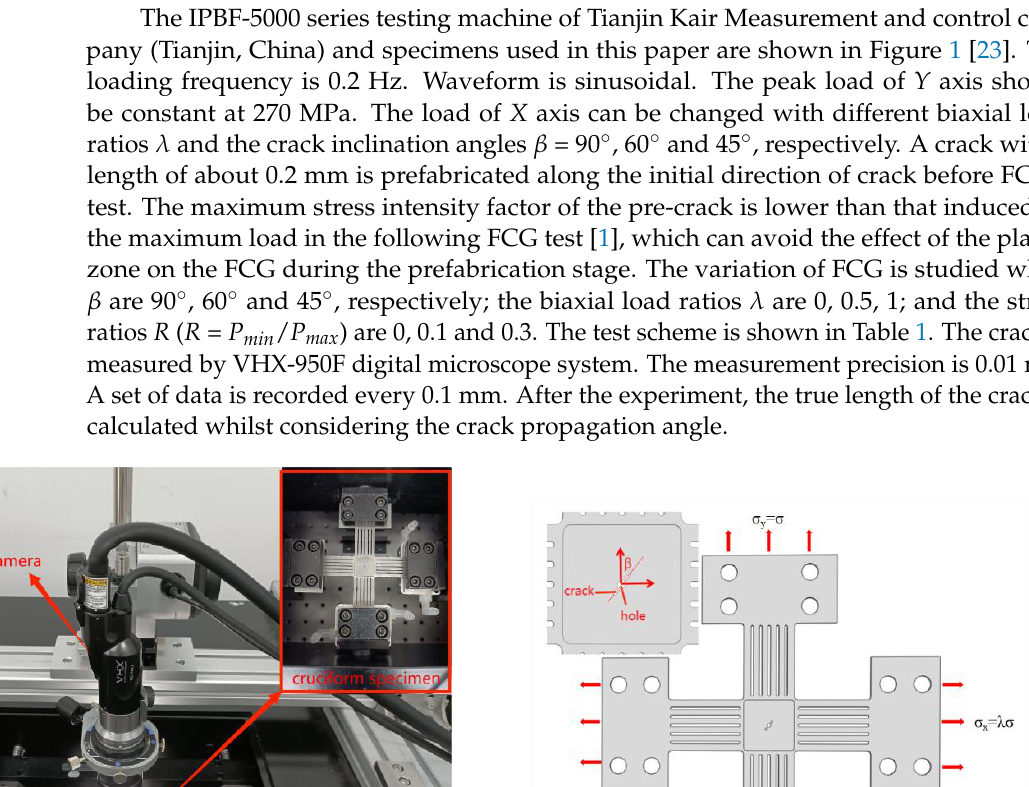
Table 1. Test scheme of biaxial fatigue crack growth of cruciform specimen.